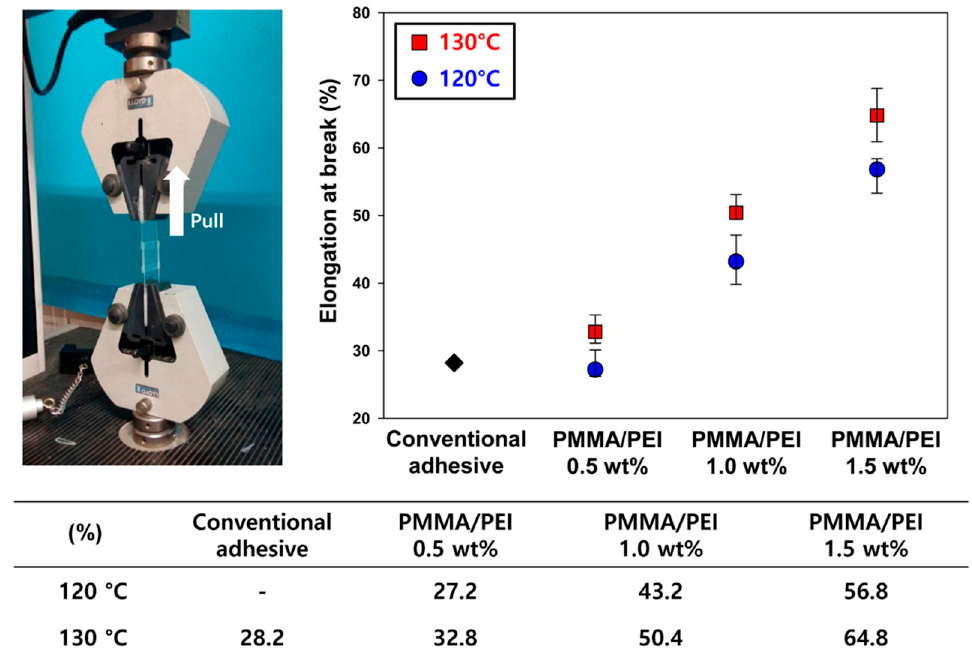
Figure 6. Elongations at break for conventional and new adhesives after heat treatment at 120 or 130 ° C.